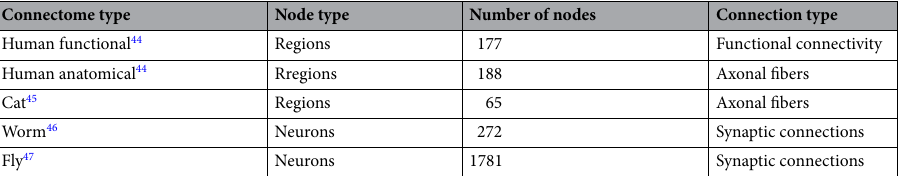
Table 1. Definitions of the connectome datasets. A description of each connectome is listed in this table. Regarding the network nodes, the type (neurons or brain regions) and the total number are given. Additionally, the table contains the type of connection used to define the connectivity strength between